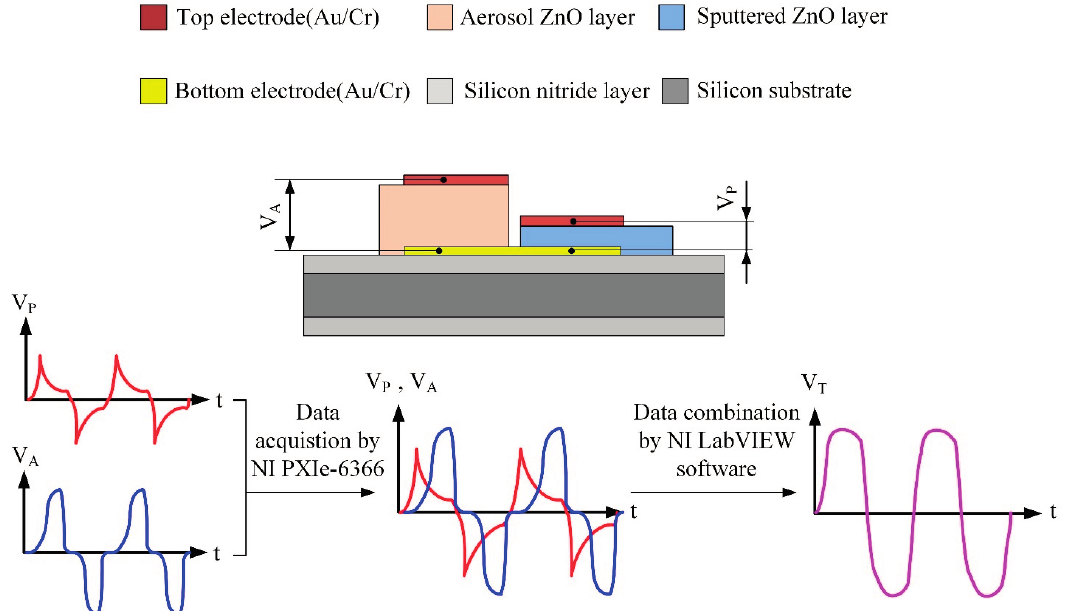
Figure 6. Schematic diagram of signal treatment flow.